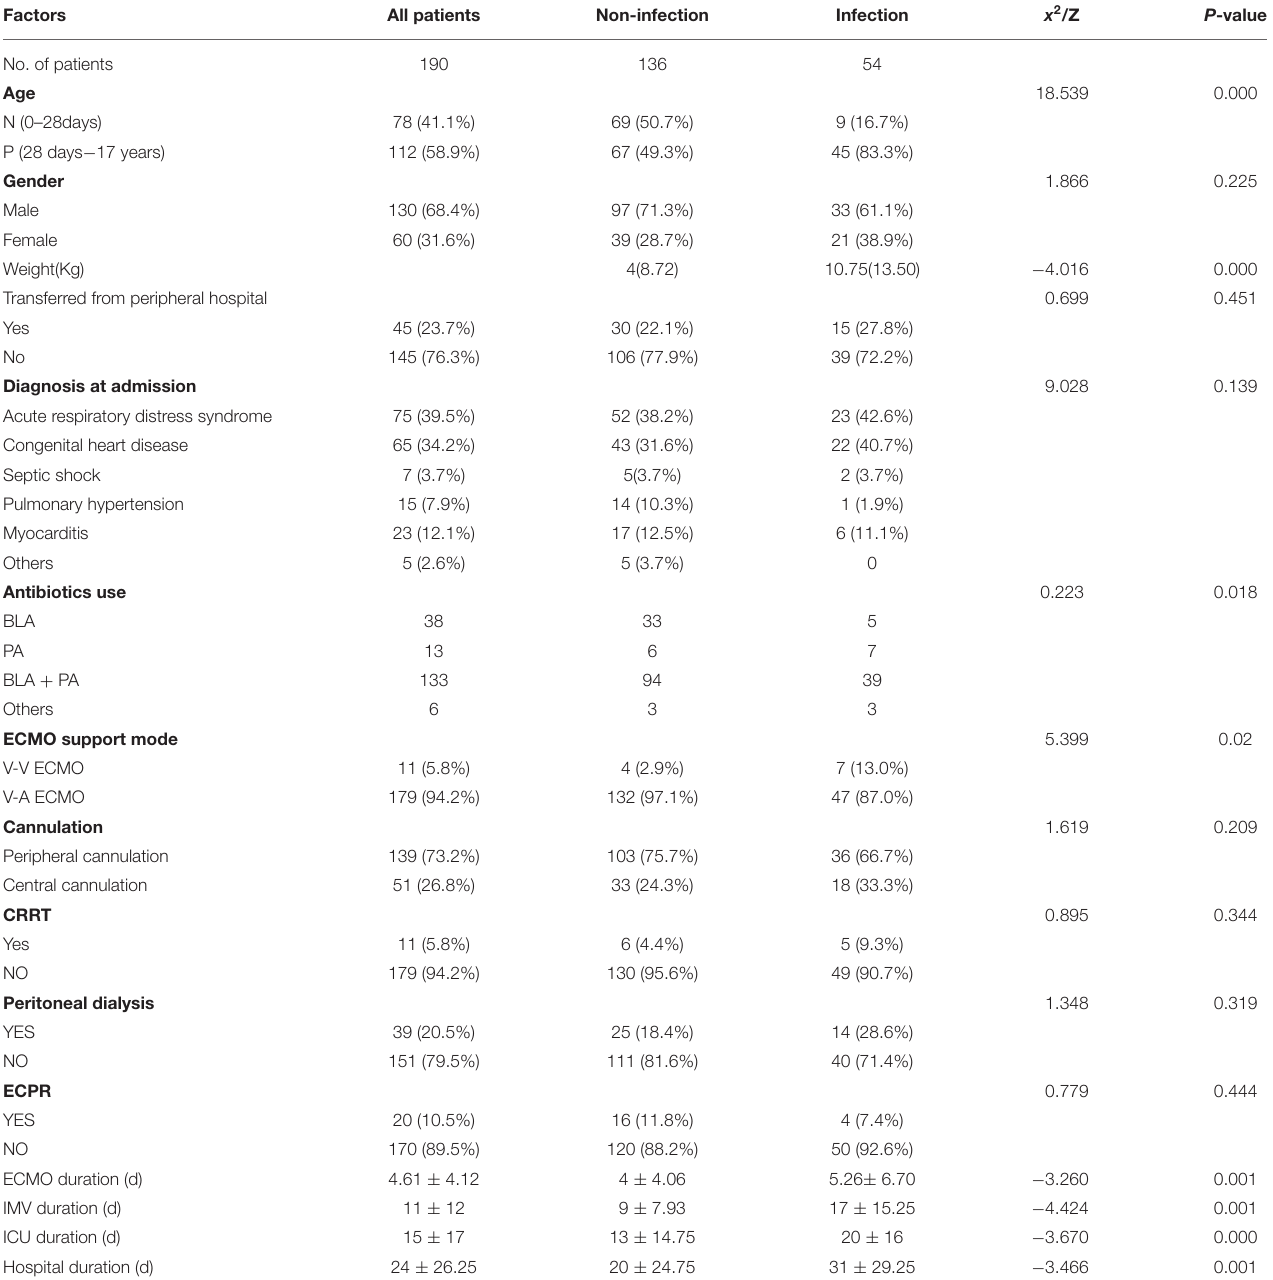
TABLE 1 | The characteristics of patients with and without nosocomial infections during ECMO. Factors All patients Non-infection